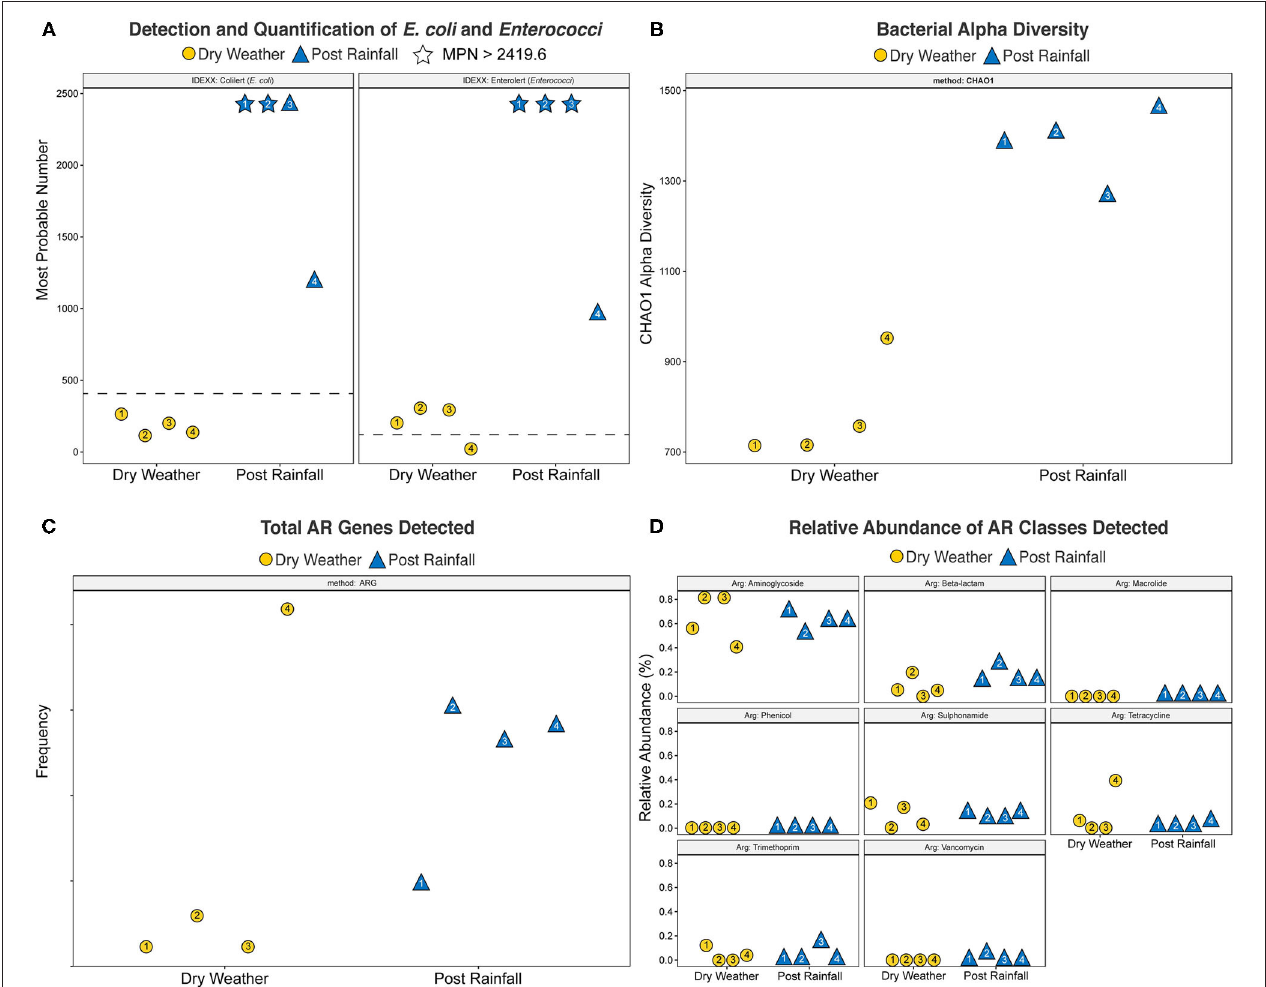
FIGURE 2 | Scatter plots of (A) Most Probable Number (MPN) of E . coli and Enterococci generated using the IDEXX Quanti-Tray system with Colilert and Enterolert media, respectively, (B) bacterial alpha diversity calculated by CHAO1 index, (C) total Antibiotic Resistance (AR) genes detected, and (D) relative abundance of AR classes detected. Yellow circles denote a dry weather sampling event; blue triangles indicate a post rainfall sampling event. Number inside each shape corresponds to site location. Plots were generated using the R software package ggplot2 (Wickham, 2016). For (A) , dotted line represents USEPA recommended water